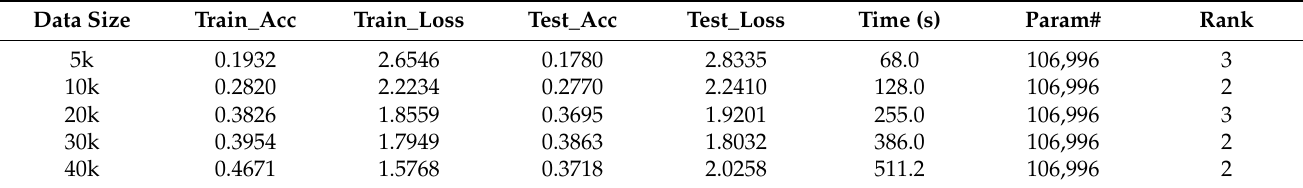
Table 7. Specific parameters and experimental results of the LSTM